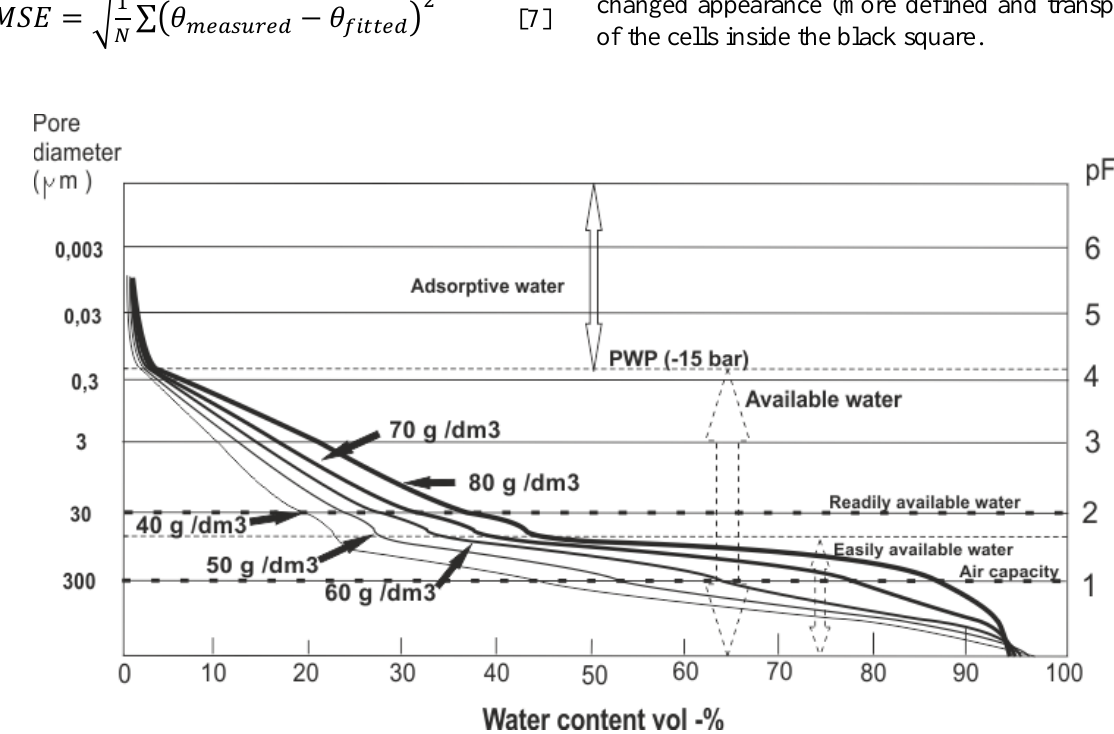
Figure 7. Water retention curves for compacted Sphagnum samples. The bulk densities ranged from 40 to 80 g dm -3